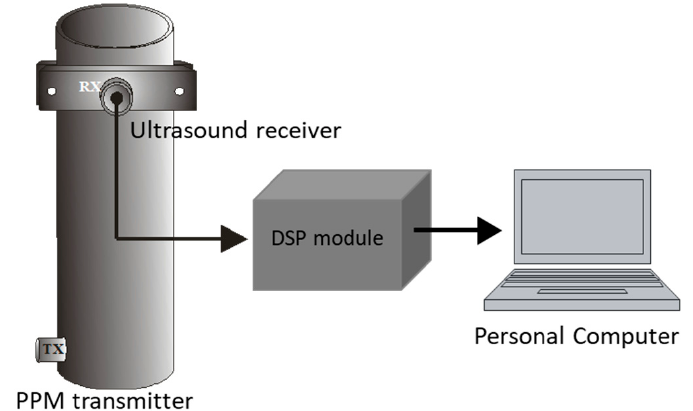
Figure 3. FMD-guided wave PPM system.